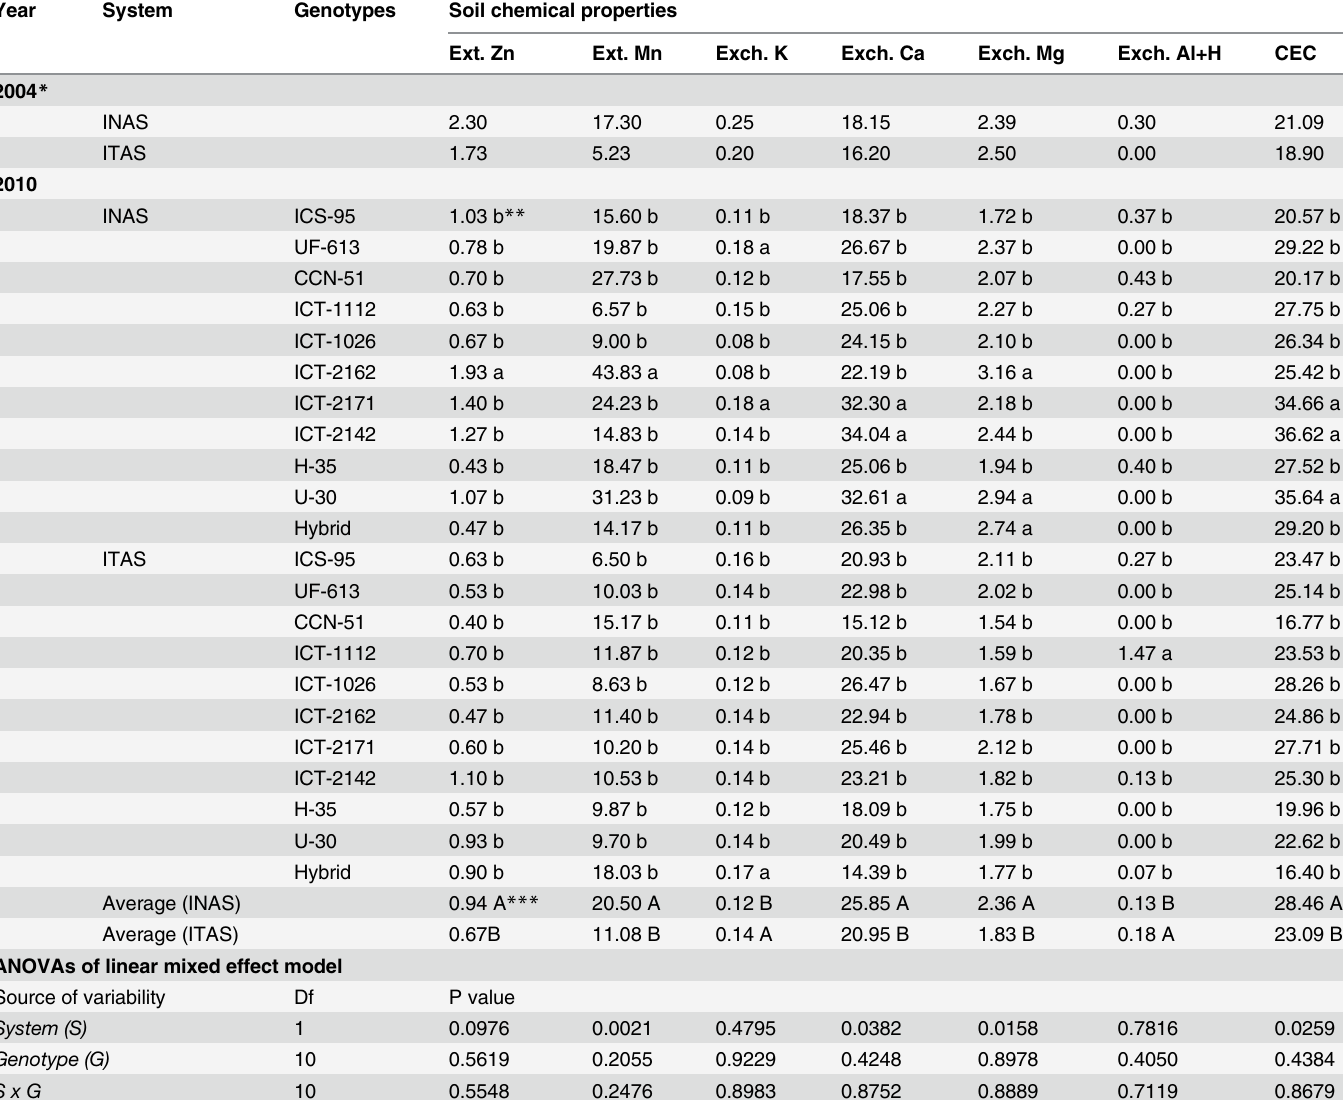
Table 9. Soil Chemical Properties: Ext Zn, Ext Mn, Exch K, Exch Ca, Exch Mg, Exch Al+H, and CEC, for 2010 Influenced by Systems of Cacao Man- agement and Cacao Genotypes at 0-20cm Depth.